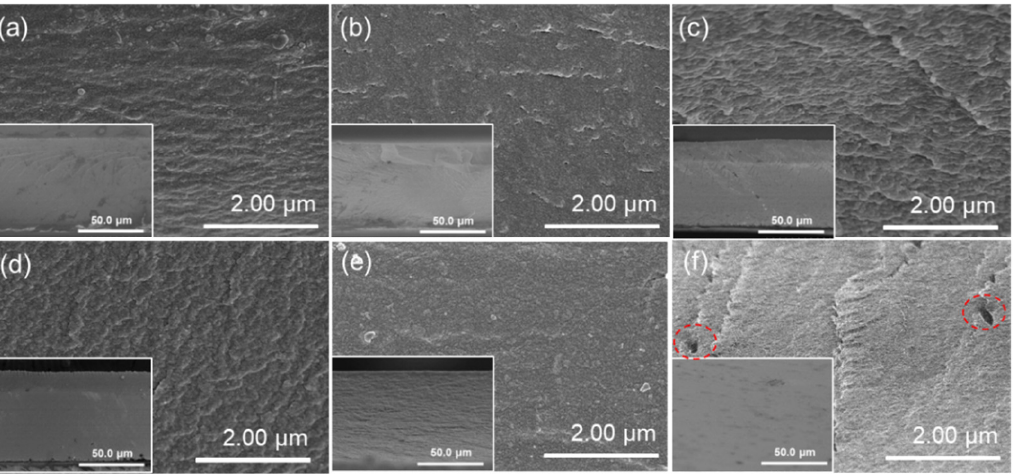
Figure 4. Cross-sectional morphologies of the PIMs with different content of carrier: ( a ) 20%; ( b ) 30%; ( c ) 40%; ( d ) 50%; ( e ) 60%; and ( f ) 70%.